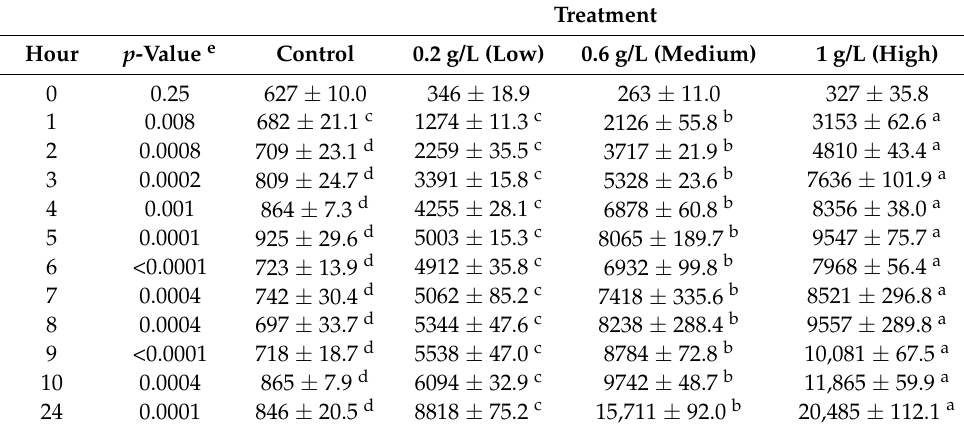
Table 3. Initial gluconic acid (mg/L) values over the first 24 h.